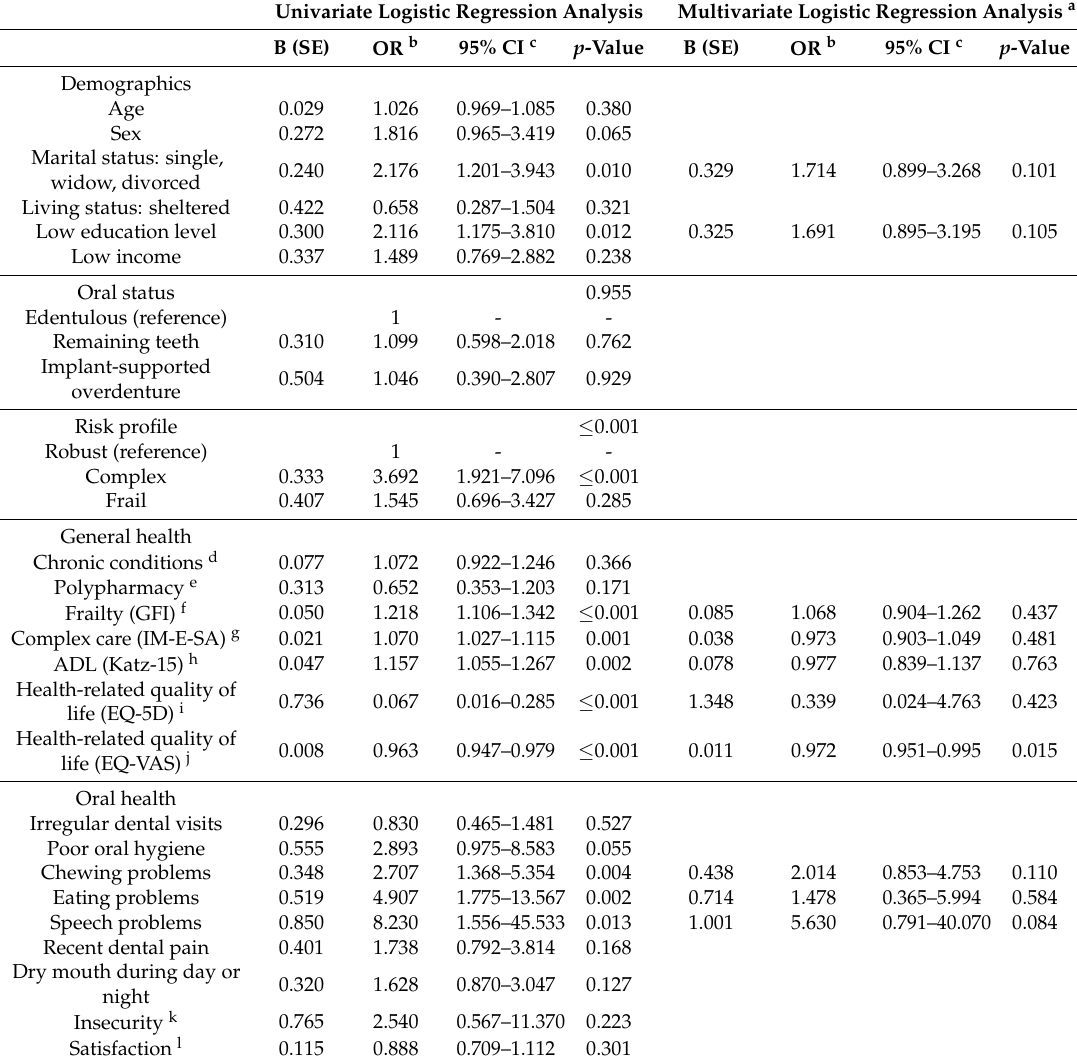
Table 3. Univariate and multivariate logistic regression analysis using nutritional status as dependent